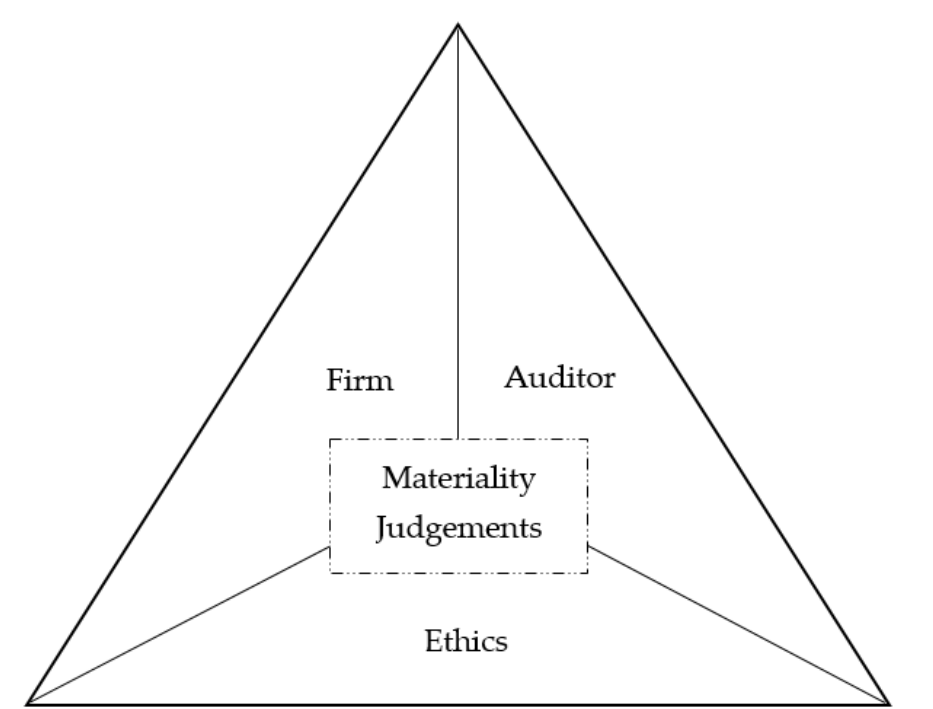
Figure 3. An audit triangle for materiality research.